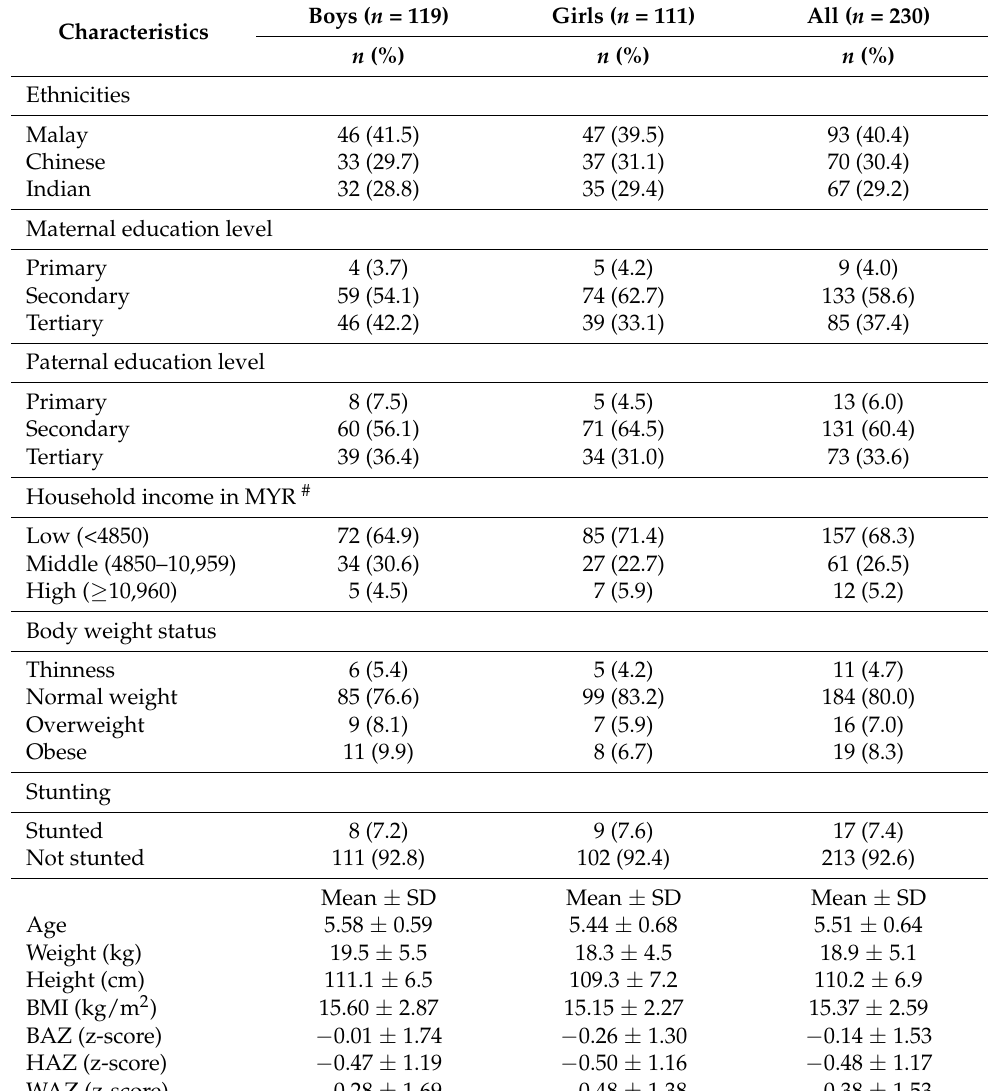
Table 1. Anthropometric and socio-demographic characteristics of preschoolers ( n =